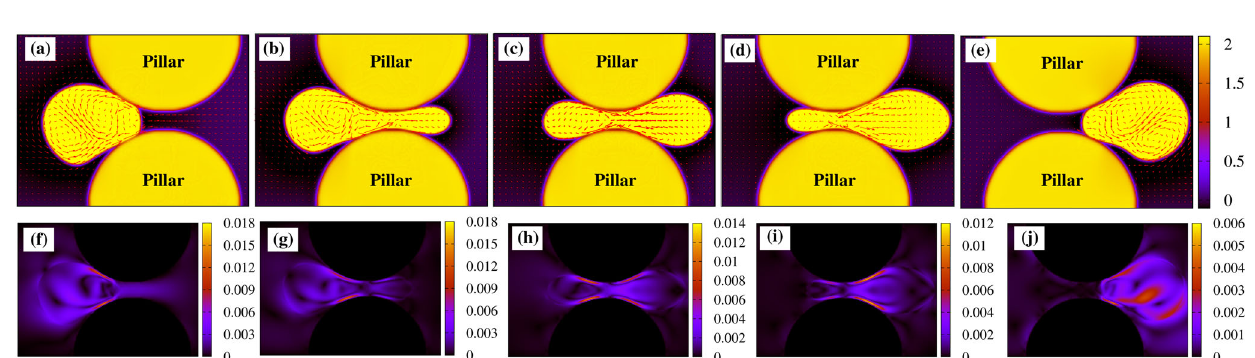
Fig.5|Velocity fi eldinanarrowconstriction. Thetoprow a – e showsthevelocity fi eld v during the transmigration with λ ≃ 0.2, while the bottom one shows its magnitude ∣ v ∣ . Here, the double vortex pattern ( a ) moves progressively backward ( b ) until it is temporarily replaced, in the middle of the pore, by a squeezed four- fold symmetric structure, in which a unidirectional fl ow pushing the drop forward